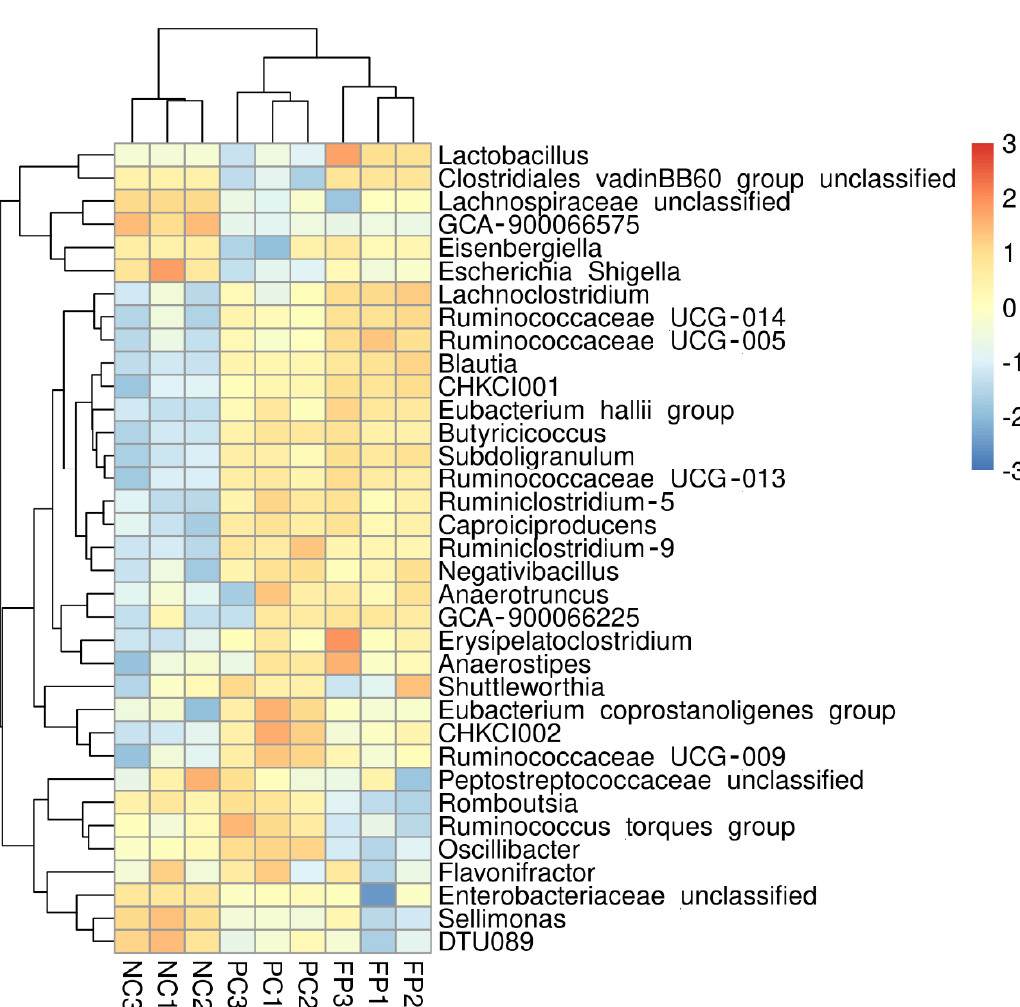
Figure 2. Taxonomic composition analysis of cecal digesta. A heatmap showing the dominant 35 genera ( y -axis) across different treatment groups ( x -axis, basal diet without treatment (NC), basal diet plus coccidial challenge (PC), and basal diet plus the coccidial challenge and 1 g/kg of B. licheniformis -fermented products (FP), n = 3).